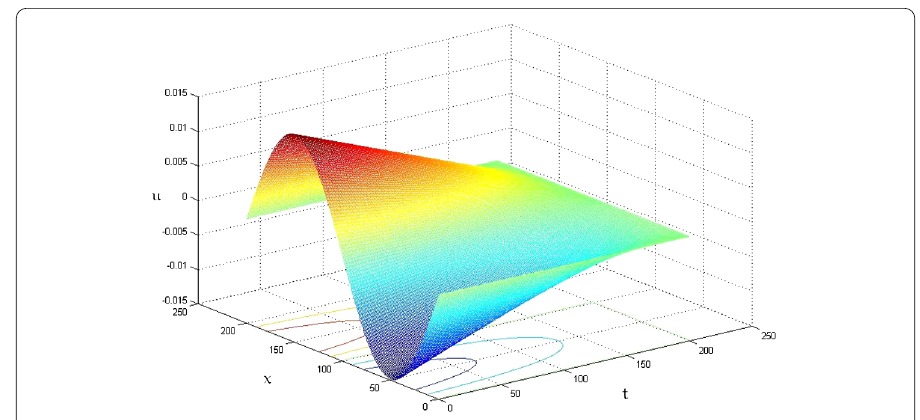
Figure 5 The OCNFDE/DEI solutions when 0 ≤ t ≤ 2.5 and 0 ≤ x ≤ 2.5